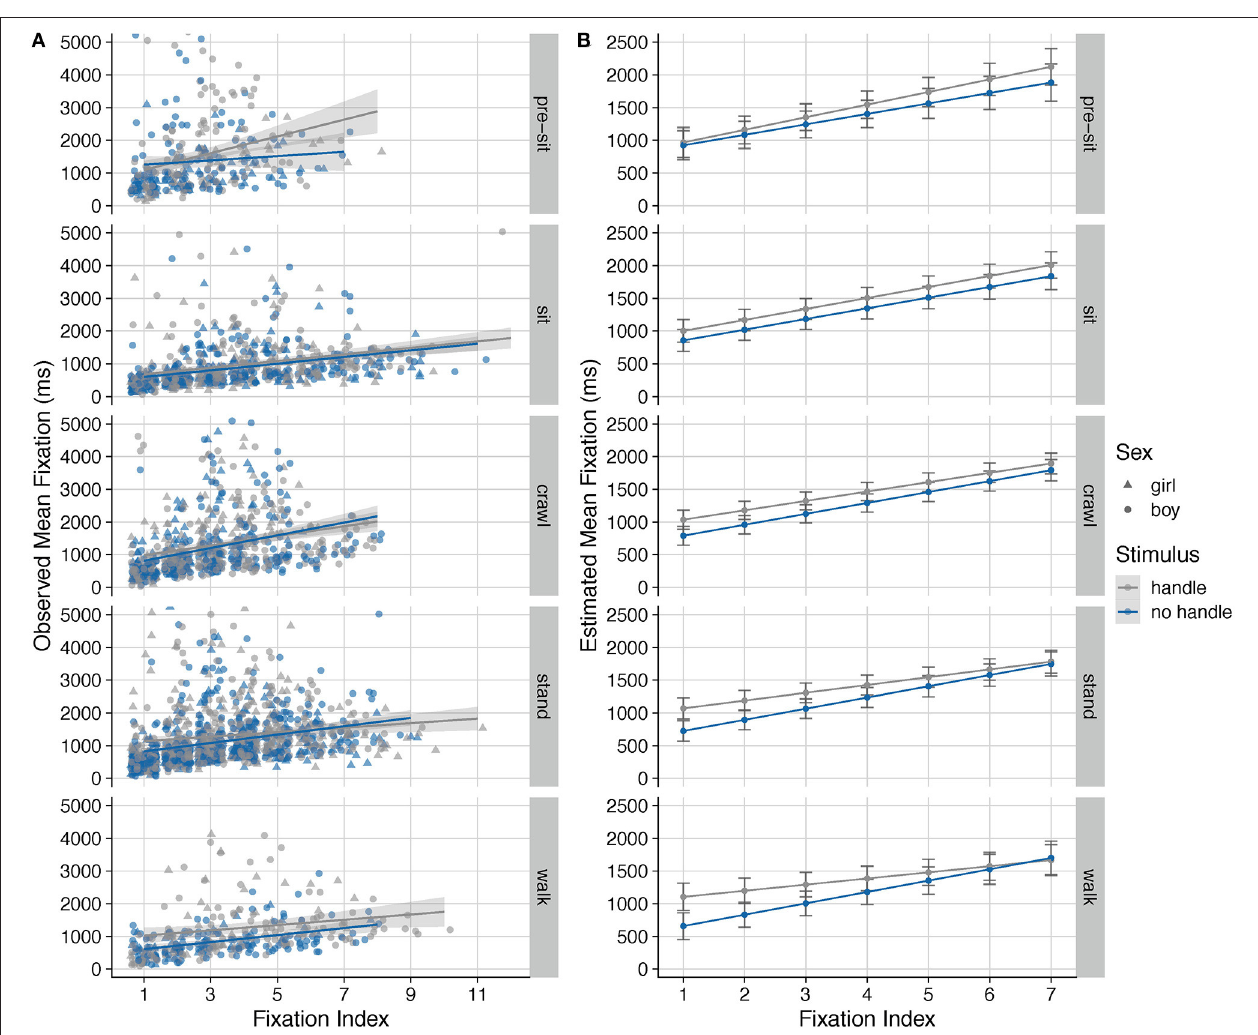
FIGURE 3 | The observed data points (one point for each look for each infant) and illustrative regression lines (A) and the estimated marginal means (B) for the duration of individual looks (in ms) to handled (pink) and non-handled (blue) objects, separately for each motor level. The figure for the observed data (A) has been artificially cut off at 5,000ms, which means that 43 looks of longer duration are not represented on the figure. The marginal means have been estimated only for the first seven fixations, as the observed data are sparse for later fixations and the estimated means will be unreliable. The error bars in the marginal means represent 95% confidence intervals. Objects came from Horst and Hout